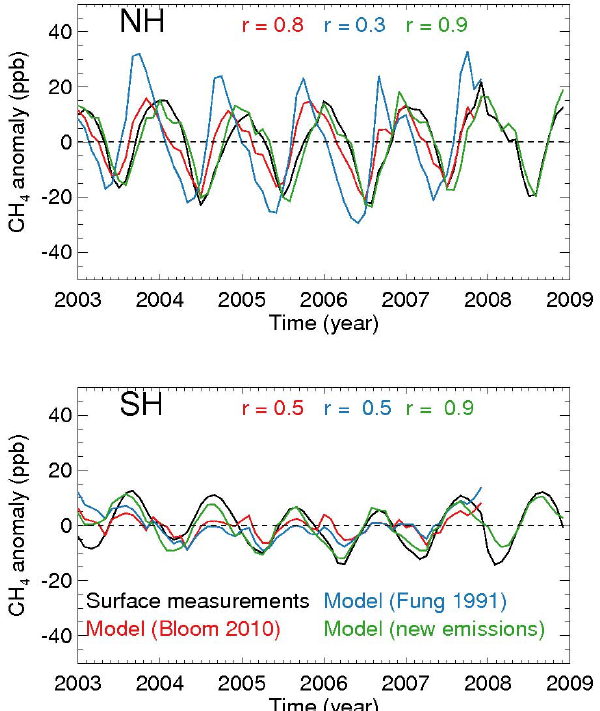
Fig. 5. Northern Hemisphere (NH, top) and Southern Hemi- sphere (SH, bottom) mean observed and model methane anoma- lies from surface concentration measurements, 2003–2008. Surface concentration measurements (black) are from the GasLab, AGAGE and ESRL networks (Francey et al., 1996; Prinn et al., 2000; Cun- nold et al., 2002; Dlugokencky et al., 2009). The GEOS-Chem global 3-D chemistry transport model (Fraser et al., 2011) is driven by wetland CH 4 emission estimates from Fung et al. (1991) (blue), Bloom et al. (2010) (red), and our new top-down approach (green).